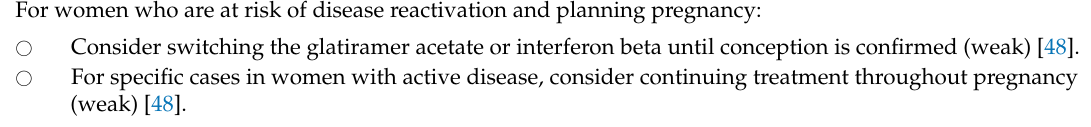
Table 3. European Committee of Treatment and Research in Multiple Sclerosis (ECTRIMS) / European Academy of Neurology (EAN) Guidelines for management of DMT in women with MS in pregnancy. Only Glatiramer Acetate 20 mg / mL is Approved for Use during Pregnancy (Consensus) [48]. For women who are at risk of disease reactivation and planning